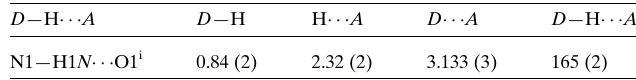
Table 1 Hydrogen-bond geometry (A˚ , (cid:4) ) for (I).